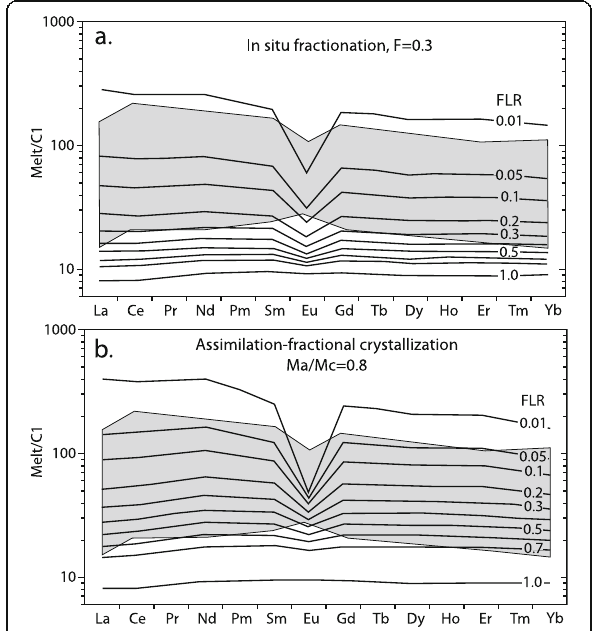
Fig. 46 C1 chondrite-normalized REE plots for crystallization models (Taylor 1985). FLR equals the fraction of liquid remaining, and the black lines describe the degree of fractionation. The gray field outlines the theoretical melt compositions based on the gabbro augite compositions. a In situ fractionation model, where only 30% of the interstitial melt is returned from the mush-zone to the central magma. b Assimilation-fractionation model, where crystallization of the DMM-derived melt takes place during bulk assimilation of the average olivine gabbro from Hole 735B (Natland and Dick 2001). The diagram demonstrates that even if the melt assimilated pre-existing olivine gabbro, the gabbros represent melts that first fractionated 50% elsewhere, but then crystallized to near